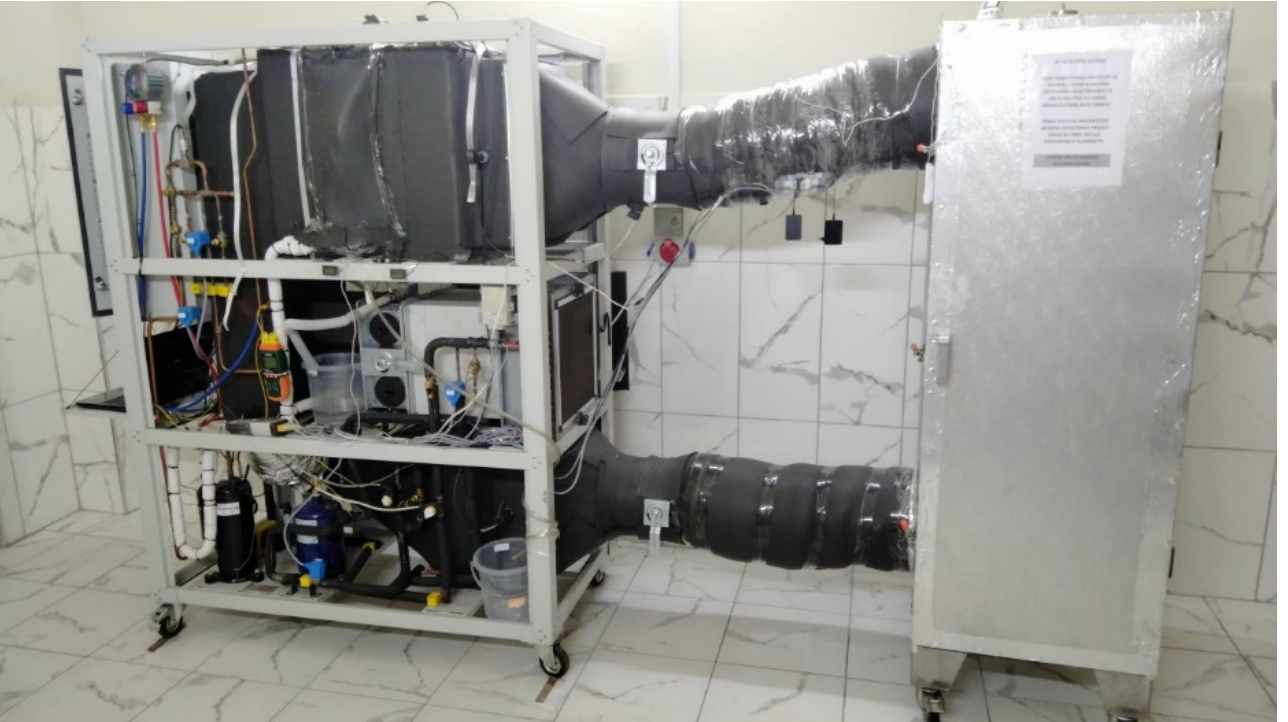
Figure 3. The closed circuit HPD system specially designed for this study.